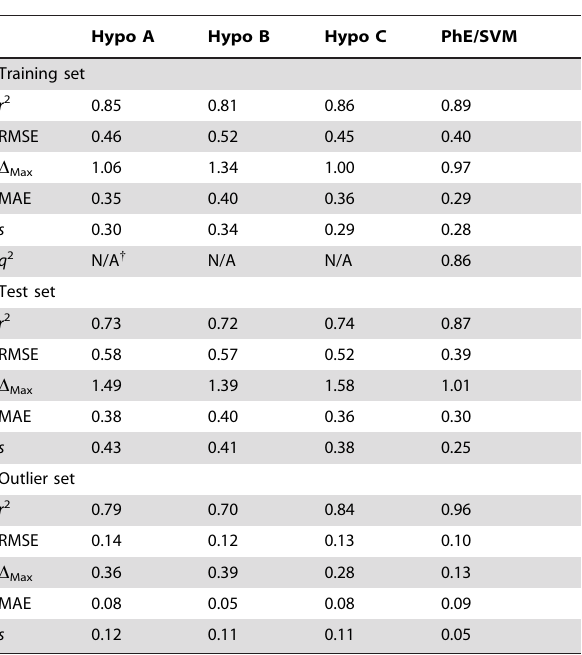
Table 1. Statistical evaluations, namely correlation coefficient ( r 2 ), RMSE, maximum residual ( D Max ), mean absolute error (MAE), standard deviation of residual ( s ) and cross-validation coefficient ( q 2 ) in the training set, test set and outlier set predicted by Hypo A, Hypo B, Hypo C and PhE/SVM.